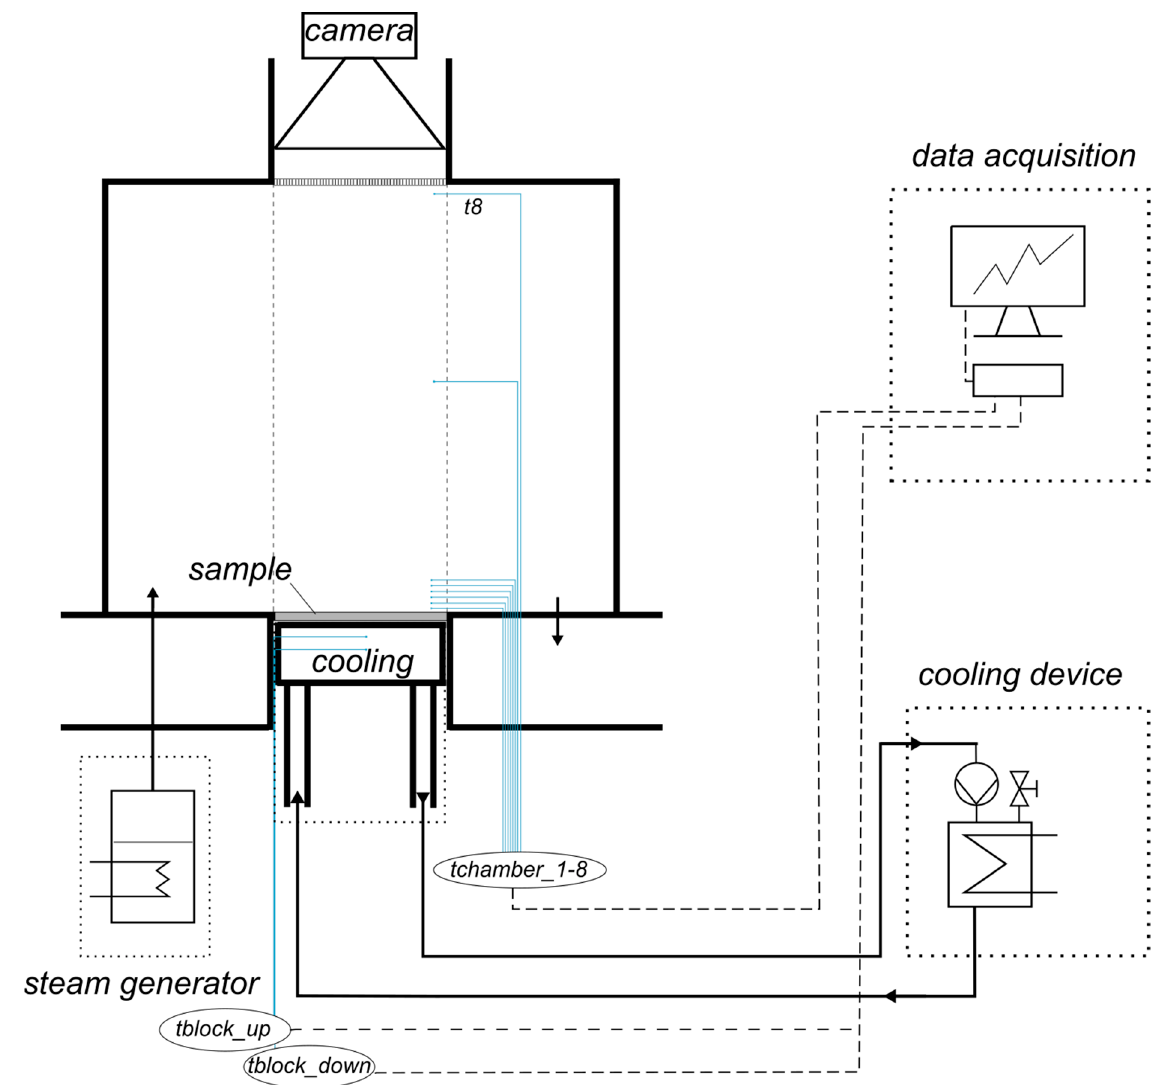
Figure 1. Schematic of the experimental setup for steam condensation.